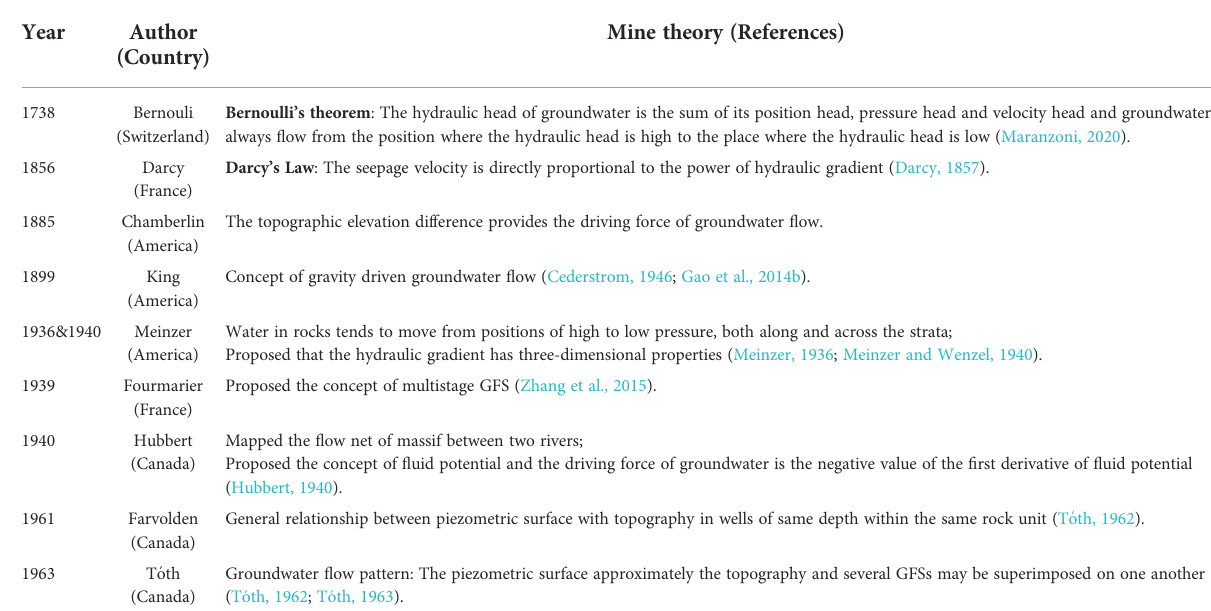
TABLE 1 Main classical theories on groundwater before To ́ thian